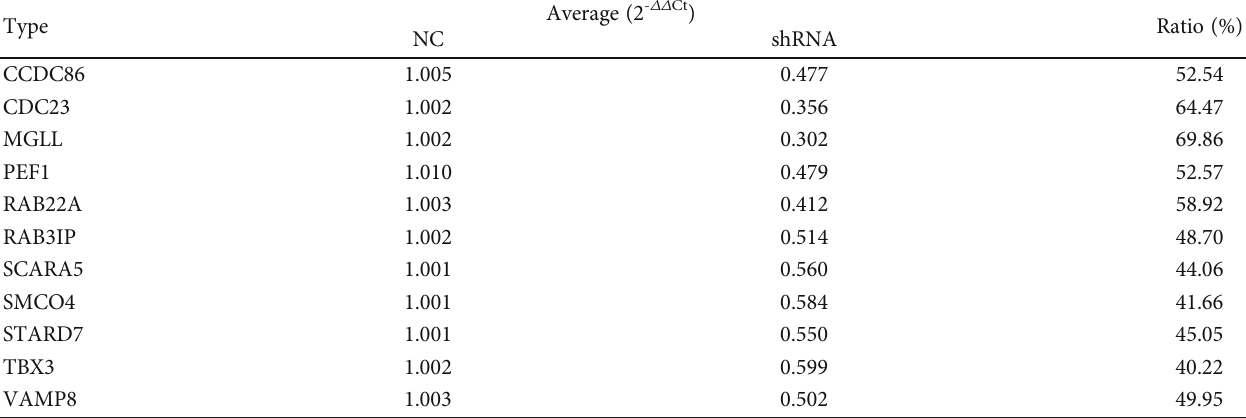
Table 2: The candidate genes with downregulation ratio of > 40% in mRNA after Thsd7a knockdown. Type